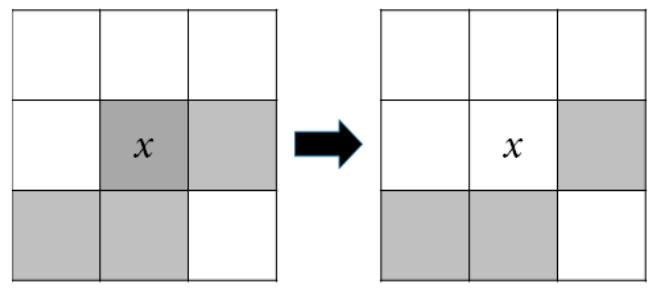
Figure 2. Thinning process example.